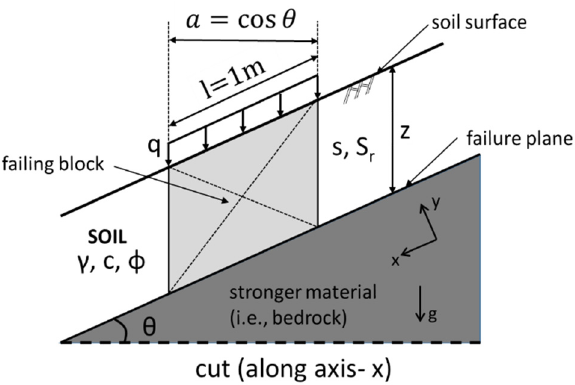
Figure 1. The analysed translational failure mechanism along a planar failure surface with slope 𝜃 .